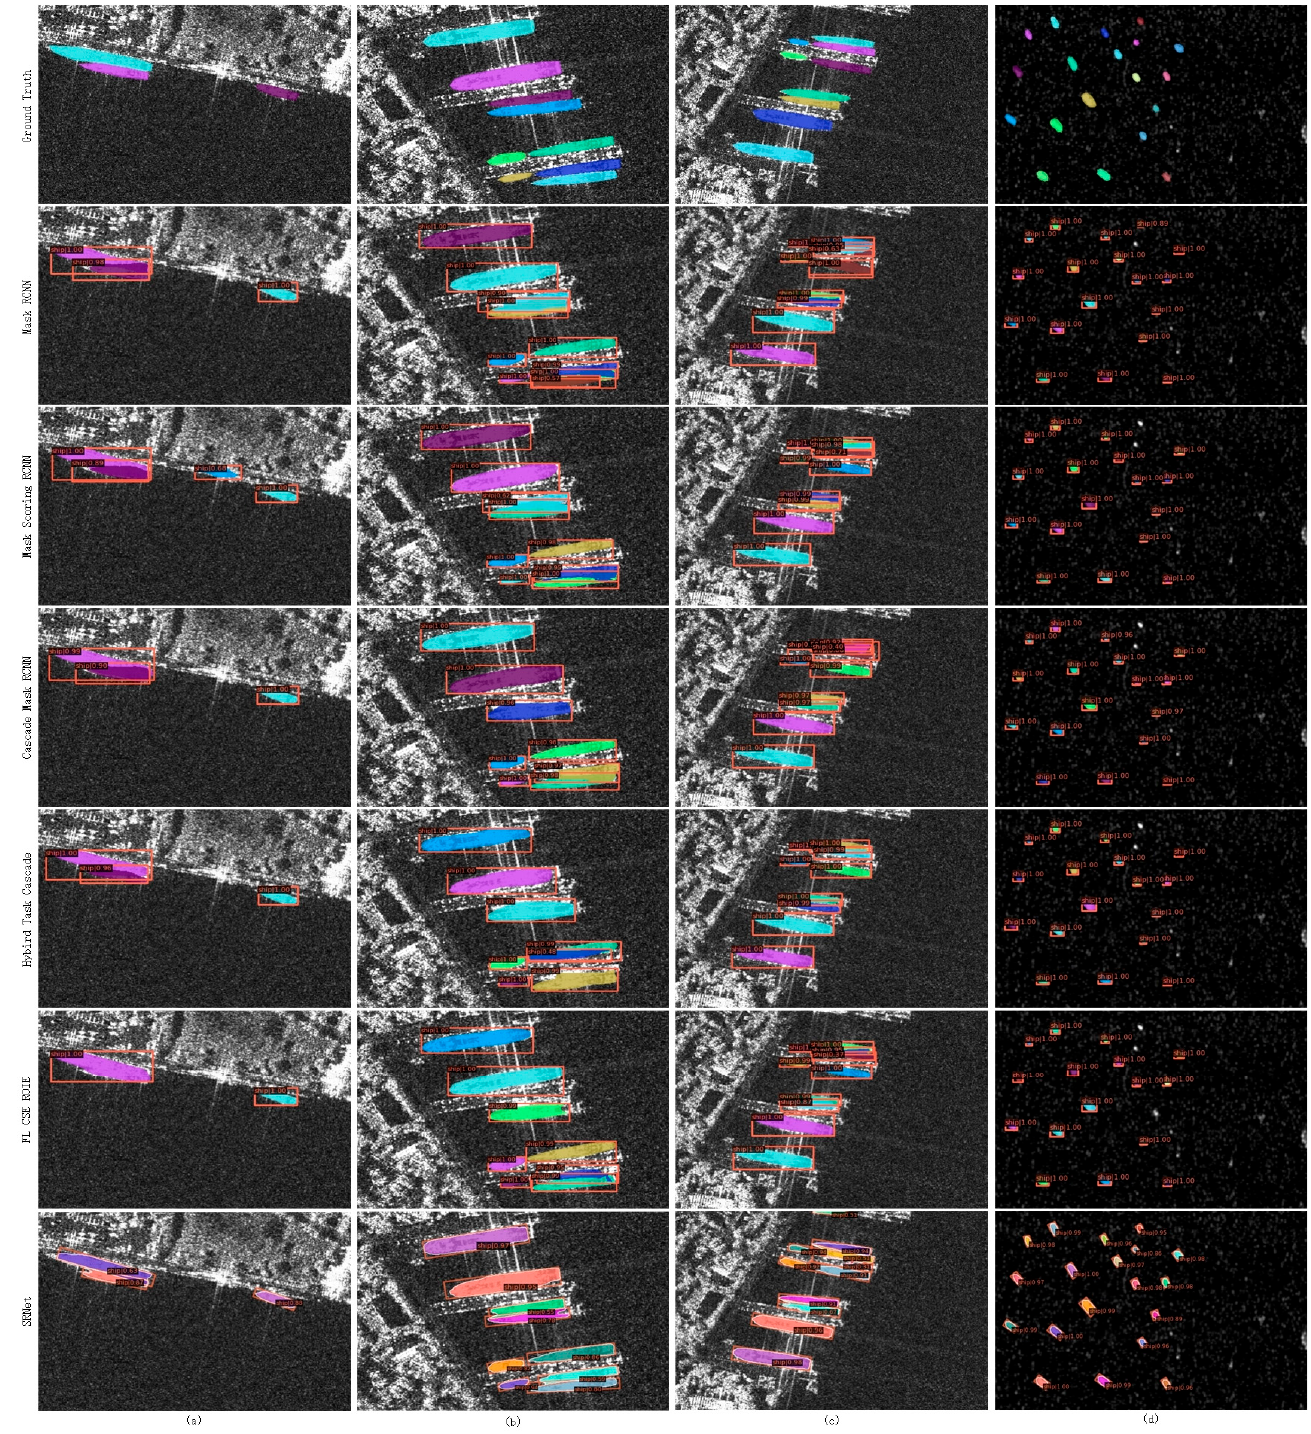
Figure 14. Four visualization illustration images of different comparison networks for instance segmentation on the SSDD dataset. ( a ) The scene of parallel ships berthing at a dock. ( b , c ) The scenes of multiple parallel ships berthing on both sides of a dock. ( d ) The scene of multiple ships sailing in the water region.